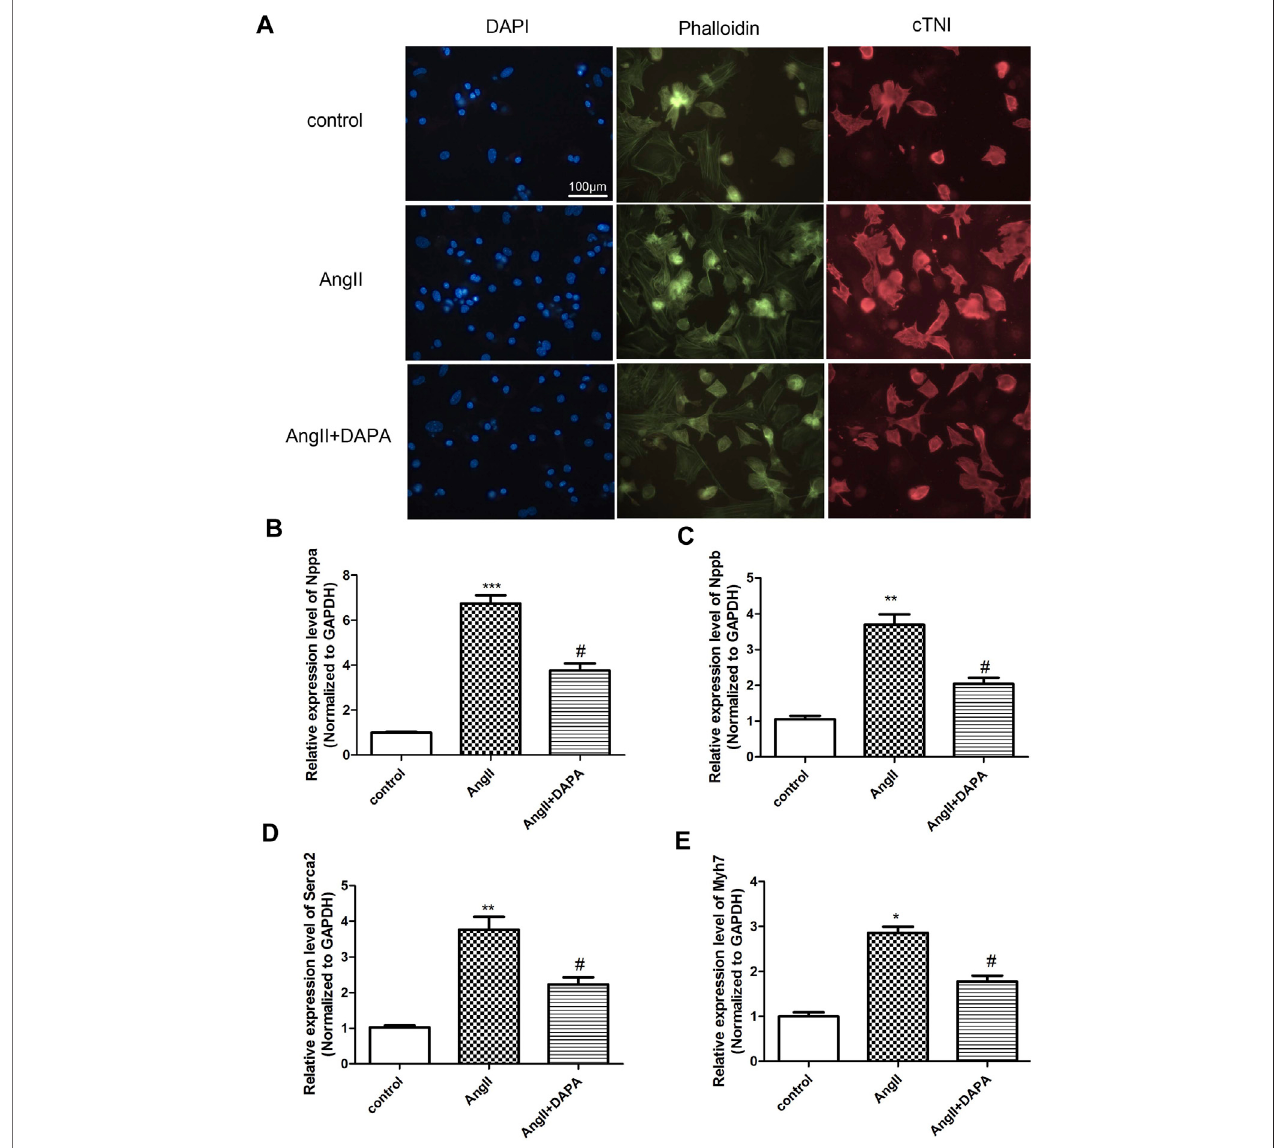
FIGURE 3 | Dapagli fl ozin attenuated AngII-induced cardiomyocyte hypertrophy. (A) The morphological changes of cardiomyocyte cells were evaluated by immuno fl uorescencestainingwithanti-cTNI(red), cellswerecounterstainedwithDAPI(blue)stainingthenucleus, Phalloidin-FITCstainingthecytoskeleton (green)qRT- PCR analysis was used to detect the mRNA expression of Nppa (B) , Nppb (C) , Serca2 (D) and myh7 (E) in different groups. The data were expressed as mean ± SD in three independent experiments, n (cid:1) 3, * p < 0.05, ** p < 0.01, vs. control group; # p < 0.05, ## p < 0.01, vs. AngII group.